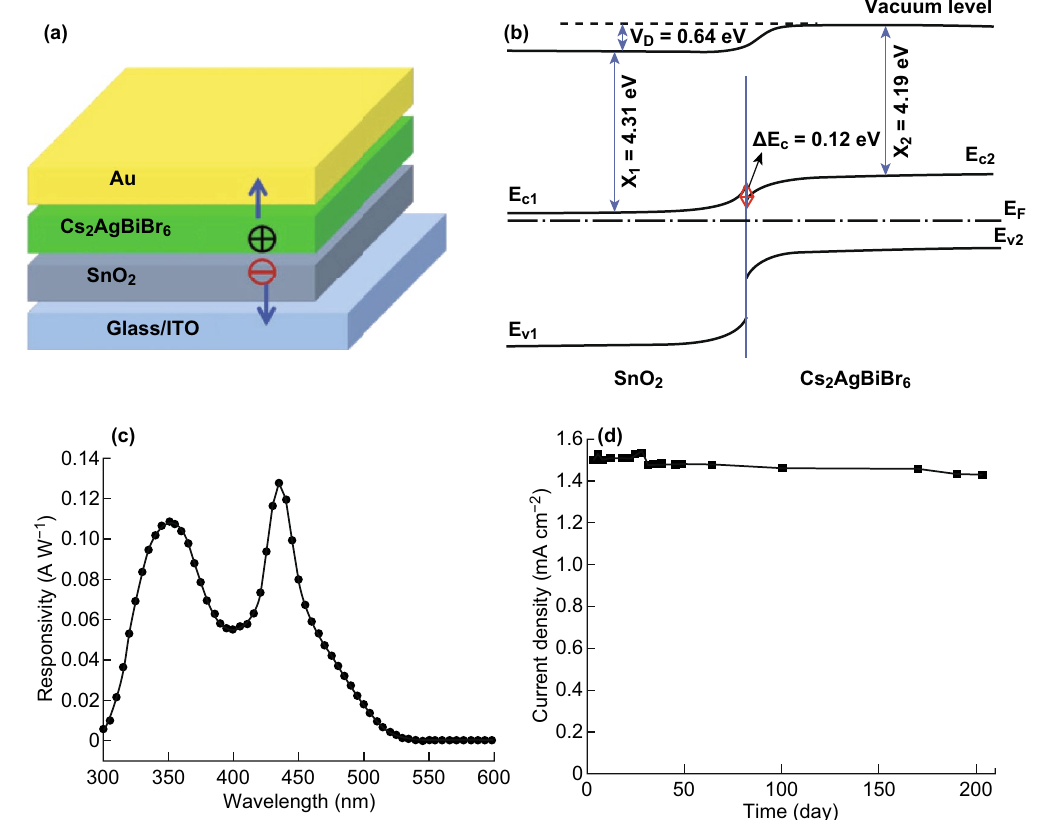
Fig. 4 a Configuration diagram of Cs 2 AgBiBr 6 -based photodetector. b Band scheme diagram of Cs 2 AgBiBr 6 /SnO 2 heterojunction. c Responsiv- ity of photodetector at zero bias. d Long-term stability test of Cs 2 AgBiBr 6 -based photodetector. Reproduced with permission from Ref.